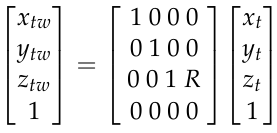
Figure 4. Definition of coordinate system for sculpturing of microlens array: ( a ) view in the 𝑦 𝑤 𝑂 𝑤 𝑧 𝑤 plane, ( b ) view in the 𝑥 𝑤 𝑂 𝑤 𝑦 plane. To generate the machined structure by tool sculpturing, the coordinates ( 𝑥 𝑡 , 𝑦 𝑡 , 𝑧 𝑡 ) of all points with a certain sampling on the tool edge should be transformed as ( 𝑥 𝑡𝑤 , 𝑦 𝑡𝑤 , 𝑧 𝑡𝑤 )